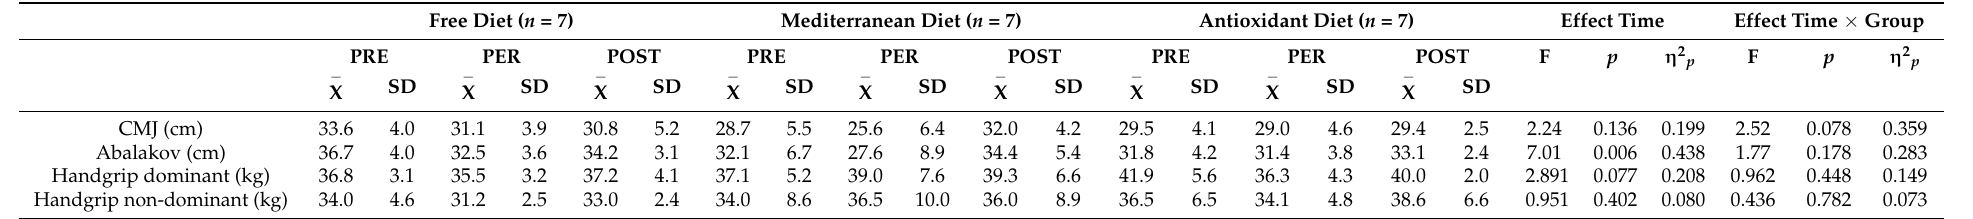
Table 7. Strength performance variables at pre-, during, and post-intervention times in the free diet, Mediterranean diet, and antioxidant-rich diet